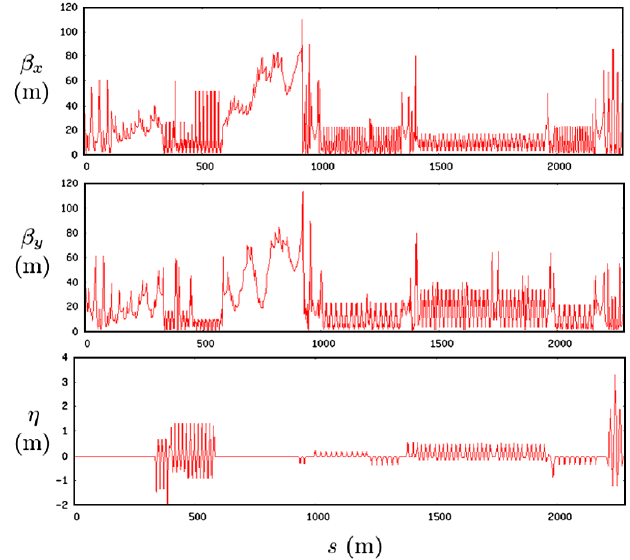
FIG. 8. (Color) Beam optics for the Cornell ERL. Top to bottom: horizontal (cid:9) - function, vertical (cid:9) -function, and horizontal dis-